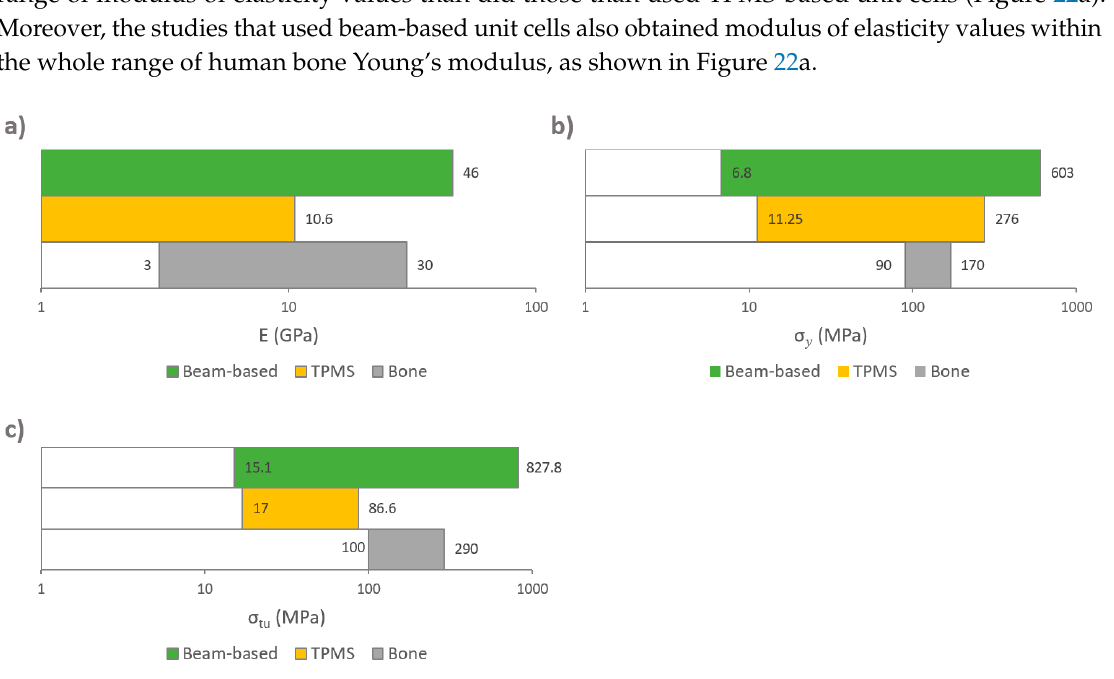
Figure 22. Comparison in logarithmic scale between mechanical properties of bone, beam-based, and triply periodic minimal surfaces (TPMS): ( a ) modulus of elasticity; ( b ) compressive yield strength; and ( c ) ultimate compressive strength.